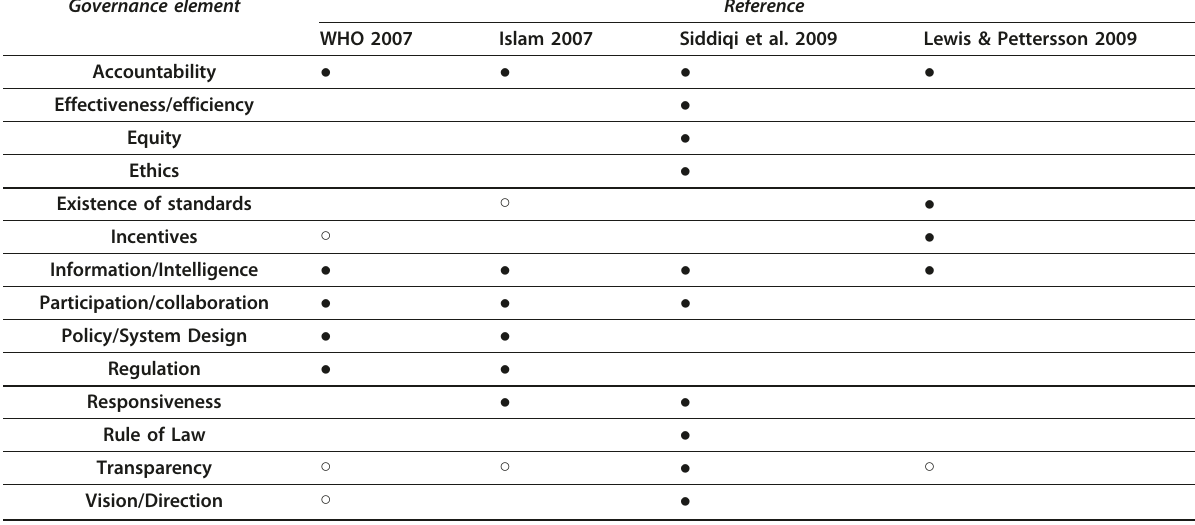
Table 2 Summary of governance elements as addressed in selected contemporary health literature Governance